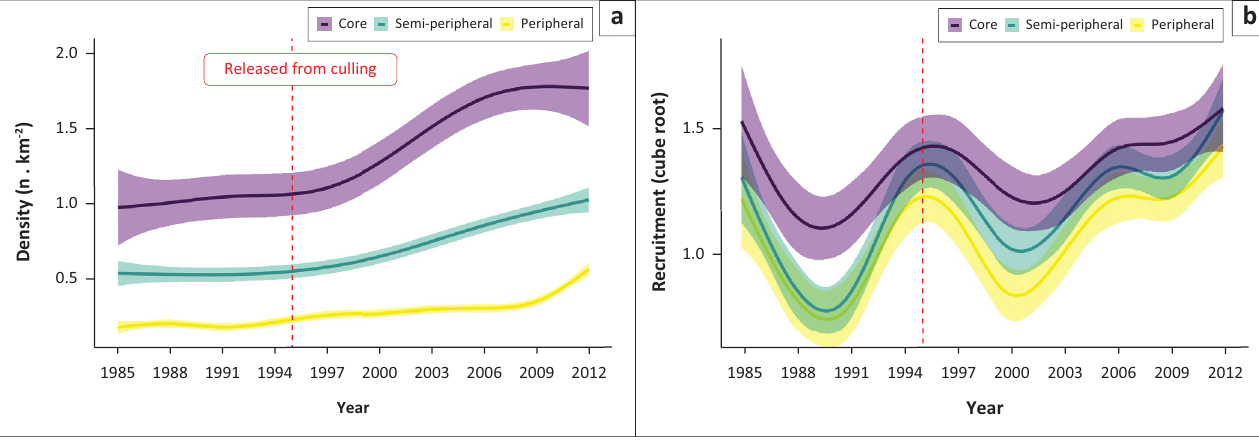
FIGURE 4: Time series of (a) elephant density per grid cell and (b) recruitment rate. The solid lines represent a smoothed conditional-means fit to the data in ggplot2. Filled regions show 95 % confidence intervals. Grid cells were classified into three zones according to the average elephant density observed in them through the study